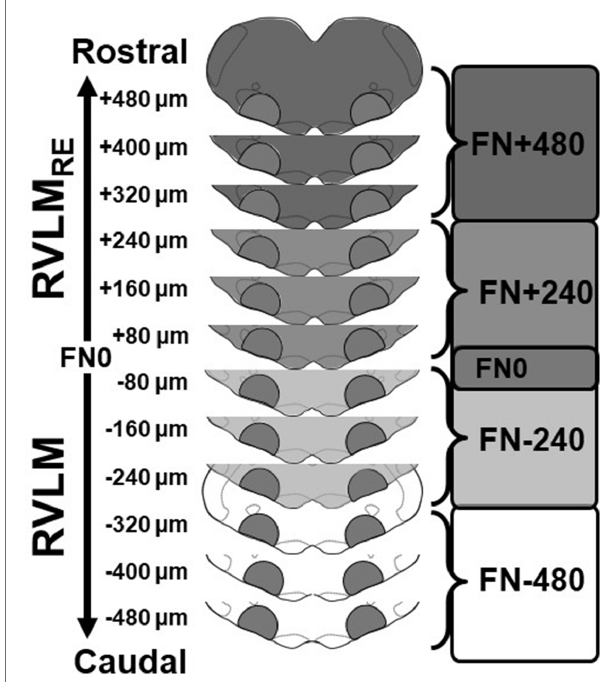
FIGURE 1 | Schematic representation of sectioning, tissue punching, and pooling of bilateral samples of the rostral ventrolateral medulla (RVLM) and its rostral extension (RVLM RE ). Medullae were cut into 80 μ m sections and punched bilaterally between the borders of the spinotrigeminal tract, nucleus ambiguus, and pyramids. Following cresyl violet staining of post-punched sections, punches were pooled according to their rostrocaudal position relative the caudal pole of the facial nucleus (designated FN0). Three punches were pooled to create two samples each containing approximately 240 μ m of the RVLM (FN-480 and FN-240; white and lighter gray, respectively) and the RVLM RE (FN + 240 and FN + 480, medium and darker grey, respectively) again, related to their position relative to